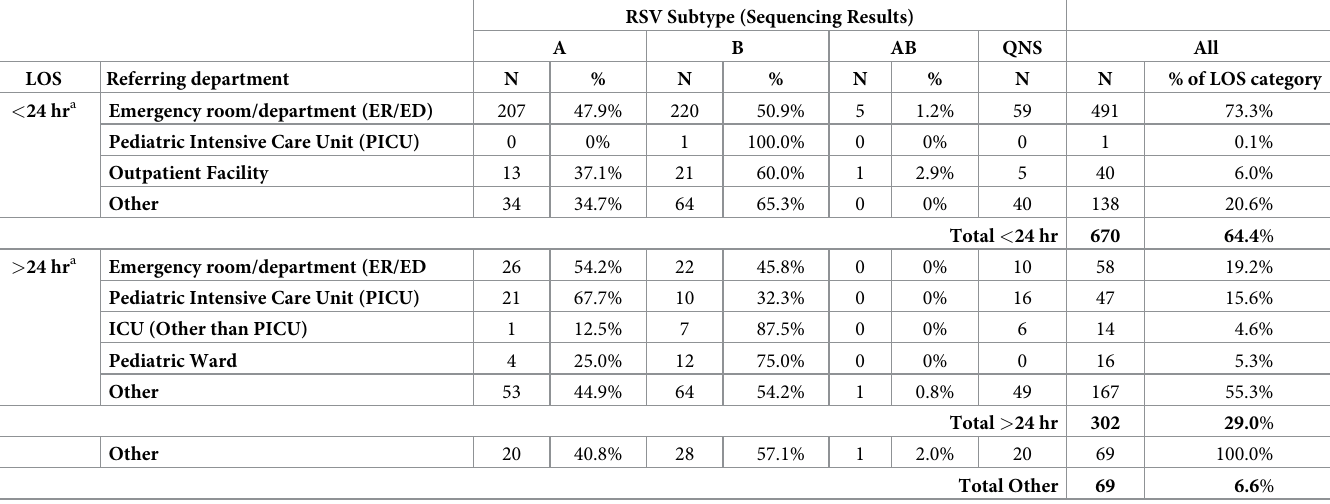
Table 4. OUTSMART 2016–17 RSV-positive tests by LOS, referring department and